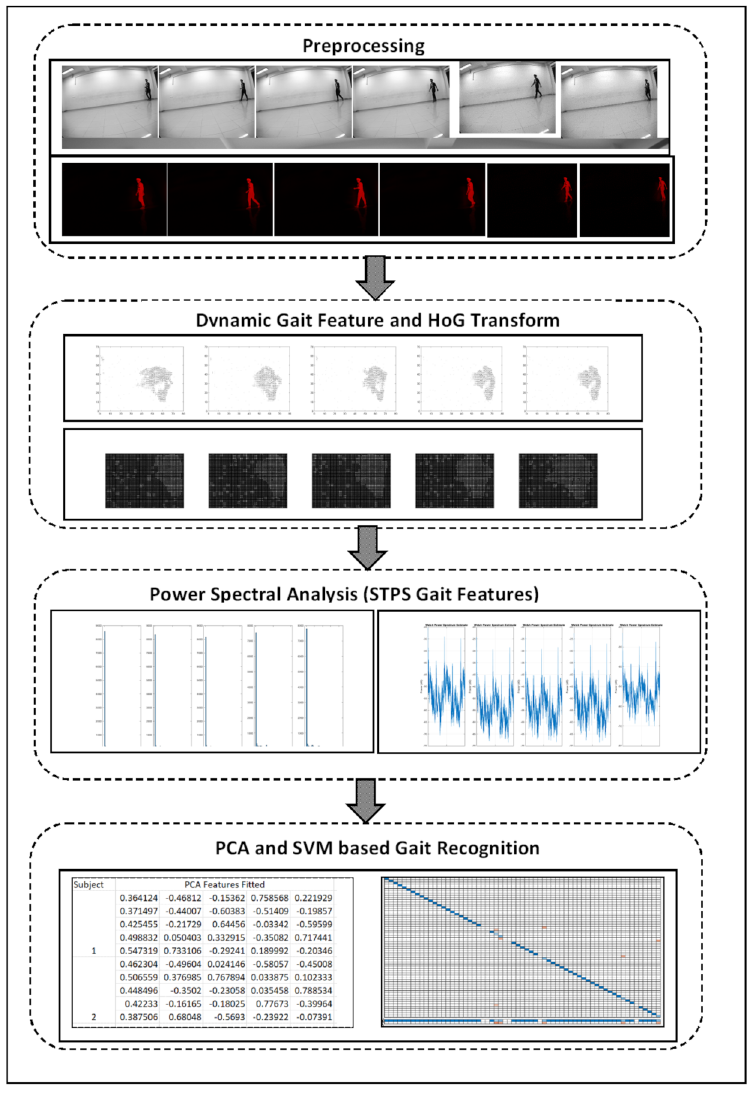
Figure 1. The framework of STPS Gait Features and SVM Classification Based Gait